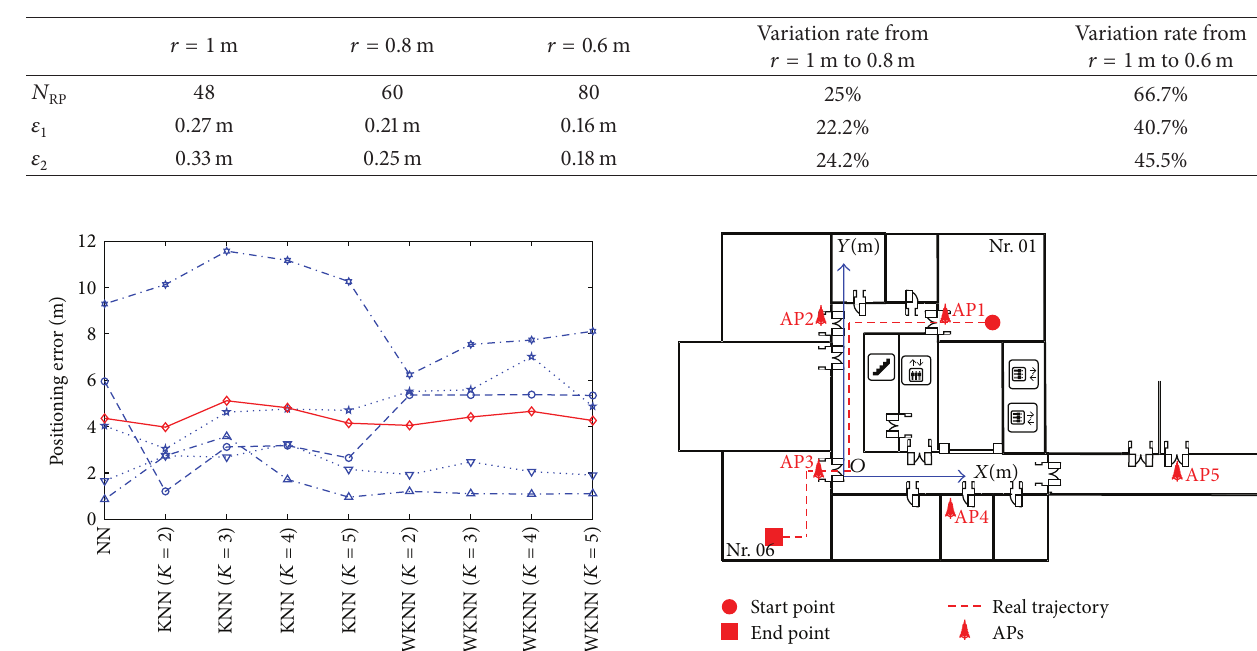
Table 2: Variations of the number of RPs and expected errors.